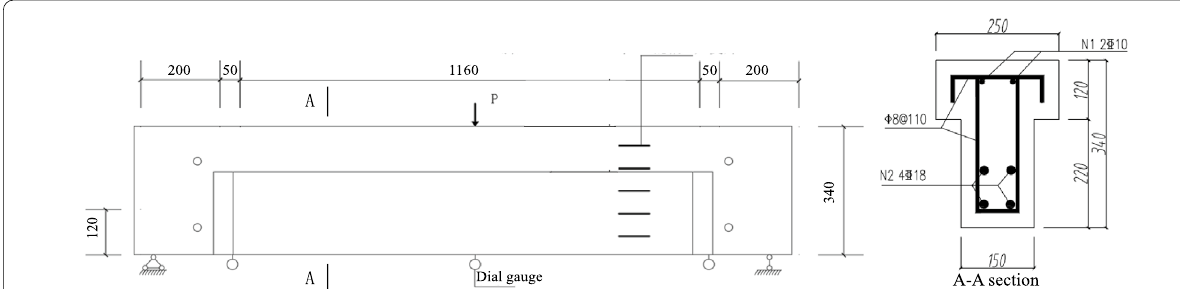
Fig.1 Layout and reinforcement of beam measurement points (unit: mm).